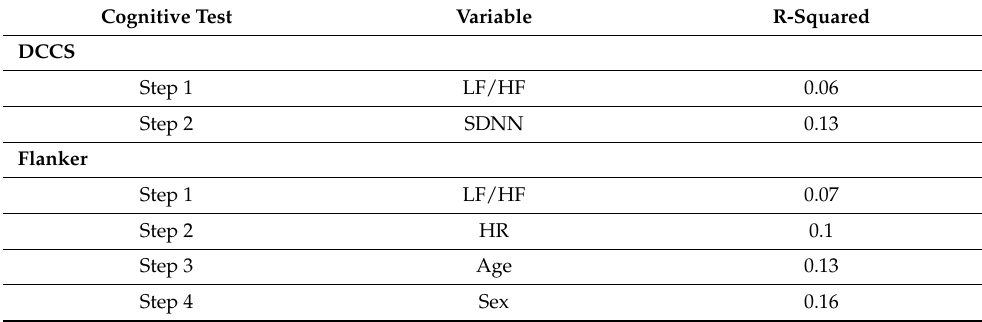
Table 6. Forward stepwise regression (F-to-enter: 1.6, F-to-remove: 1.5). Sex, age, height, weight, BMI, activity levels, HR, SDNN, and LF/HF were independent variables. All cognitive testing scores were dependent